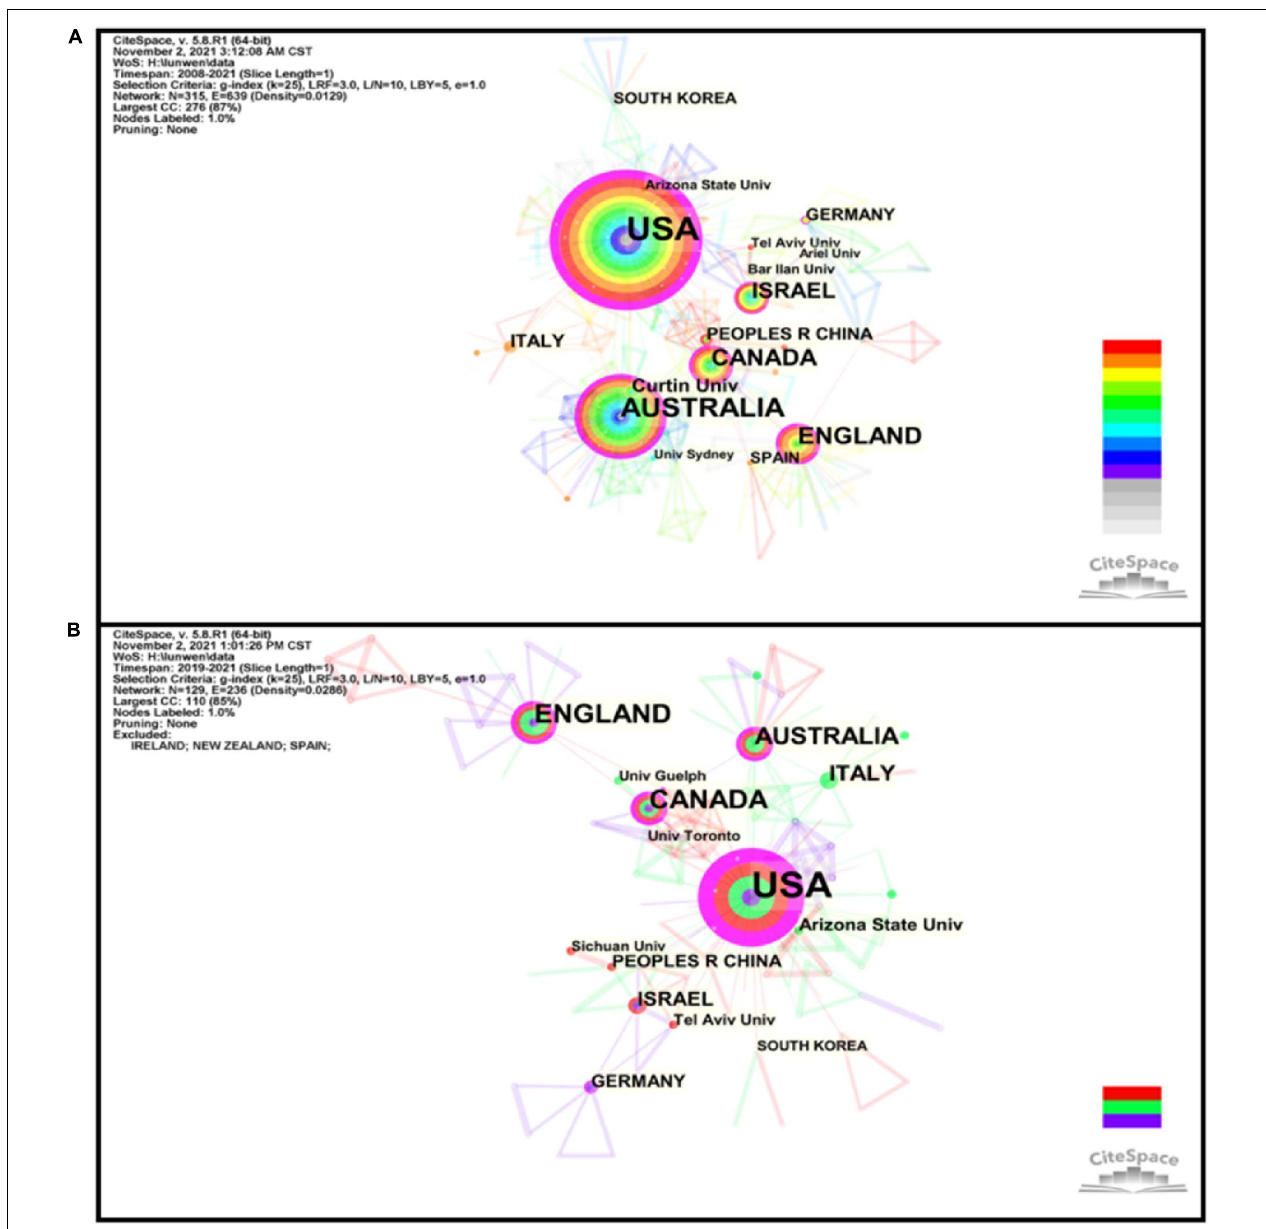
FIGURE 4 | Institutions-countries hybrid network of publications in the field of CF and PR during 2008–2021 (A) and the COVID-19 pandemic (B) . The individual circle indicates one country or institution, and the size of the circle was weighted by the number of articles published by countries or institutions. The link between two nodes represents partnership, and its thickness was weighted by the frequency of collaborations. The purple rims of circles indicate high betweenness centralities.